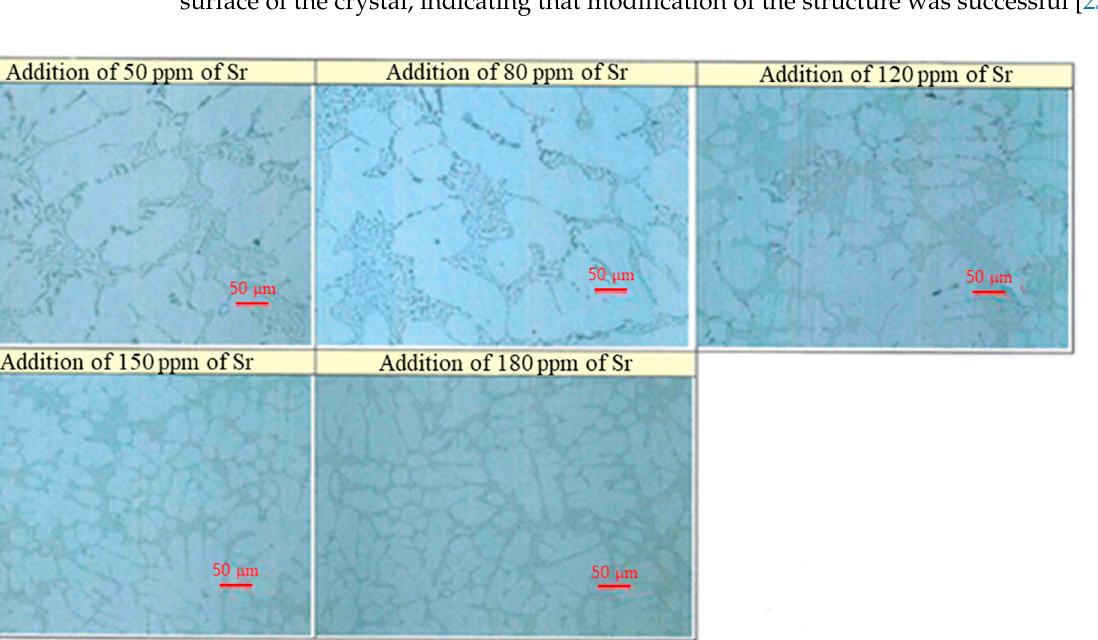
Figure 5. Comparison of Si structures formed by adding various amounts of P to the molten alloy.